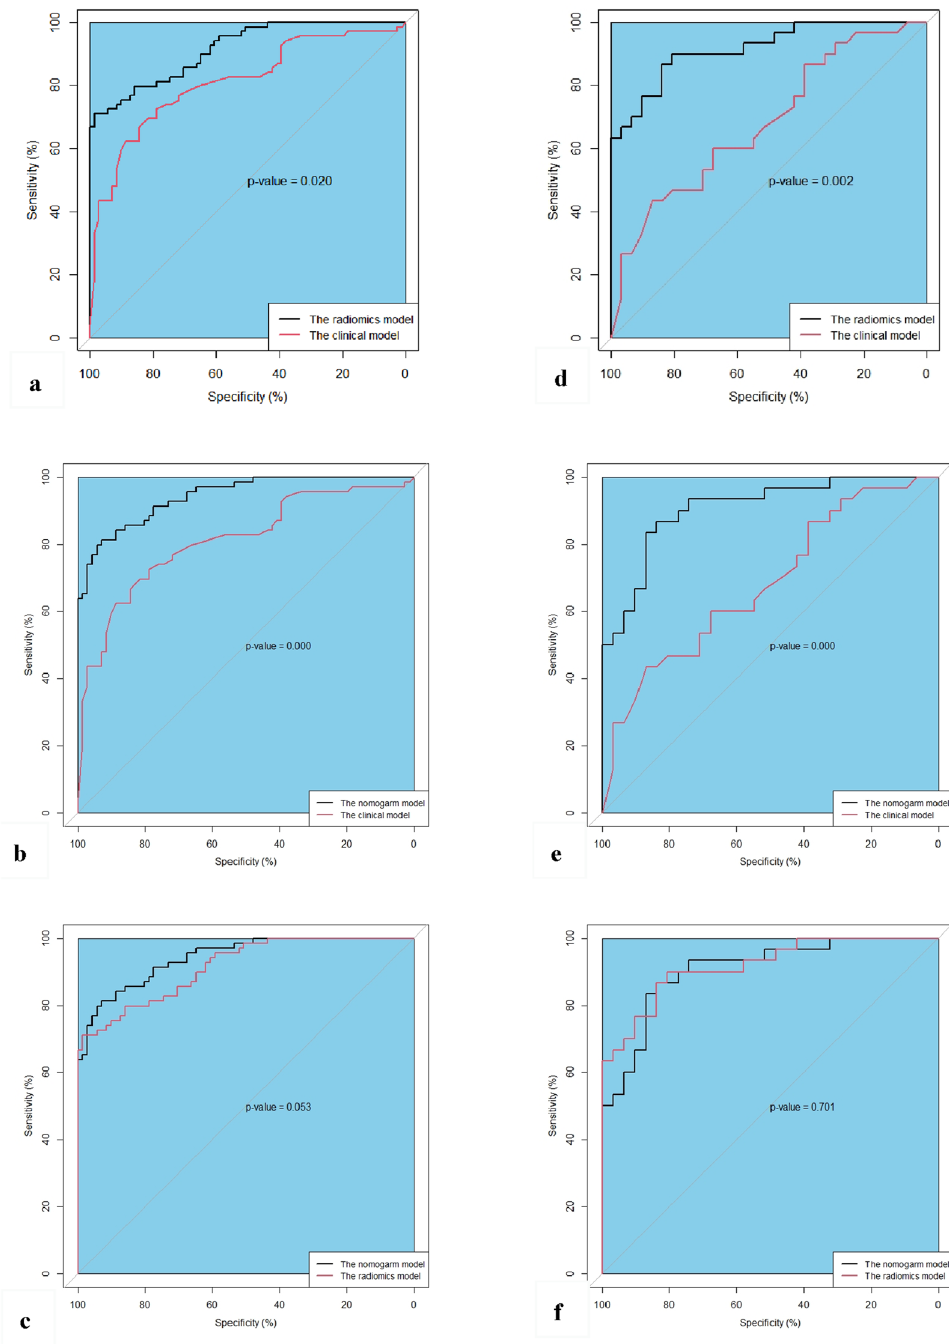
Figure 5. Comparison of the AUC among the three models in the training cohort ( a – c ) and testing cohort ( d – f ). AUC, area under the receiver operating characteristic